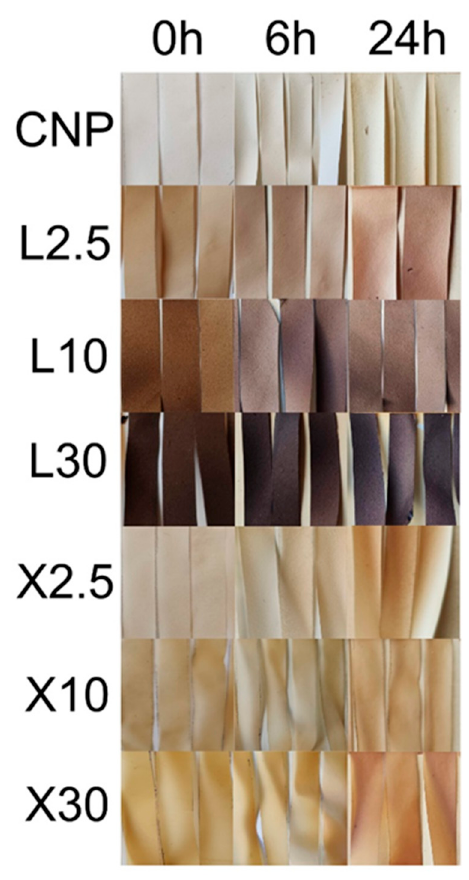
Figure 5. The visual appearance of NP before and after exposure to intensive UV irradiation at 80 °C.